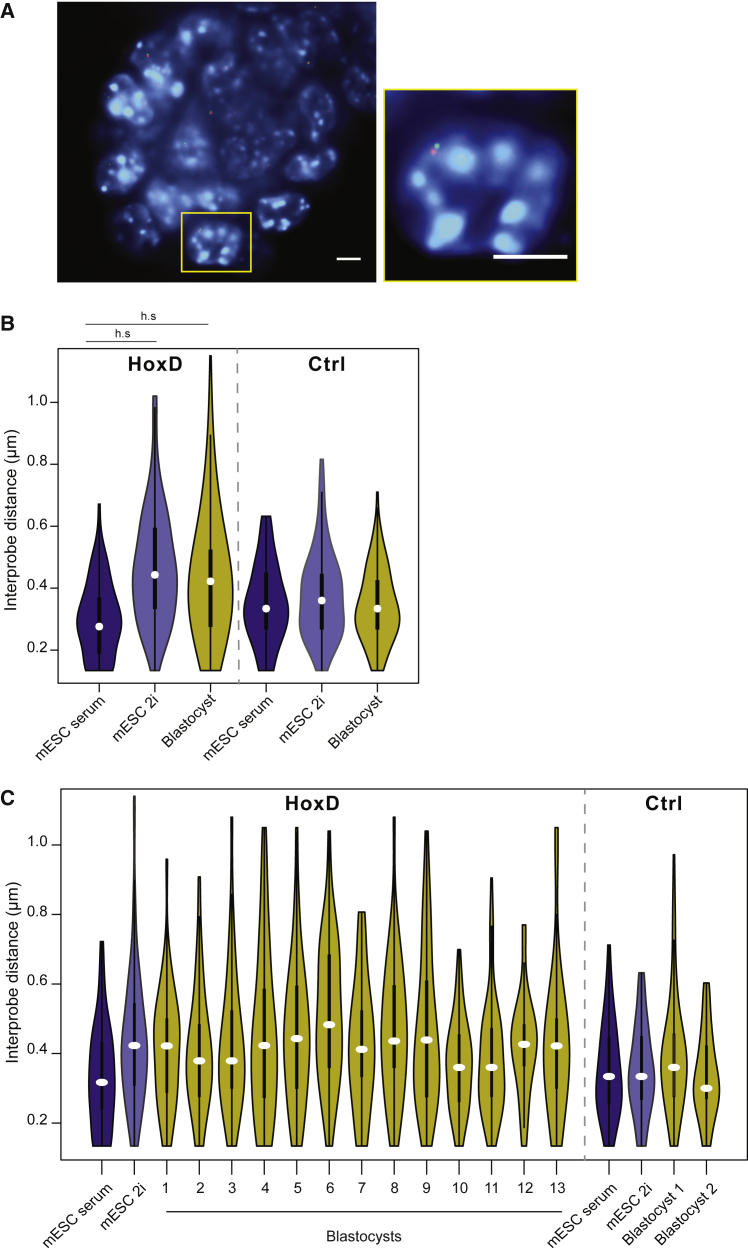
HoxD Chromatin Compaction in the Pre-implantation Blastocyst(A) Representative image of a DAPI-stained (blue) whole E3.5 blastocyst following FISH with probe pairs (red and green) detecting the HoxD locus. Inset shows enlargement of one nucleus. Scale bars represent 10 μm.(B) Violin plots showing the distribution of inter-probe distances (μm) for HoxD and control (Ctrl) loci in E14 mESCs grown in serum or 2i, and in E3.5 blastocysts. Data are presented as in Figure 1C. h.s. = p < 0.0001. Full details of statistical analysis are in Tables S1 and S2.(C) As in (B), but for data from 13 individual blastocysts.